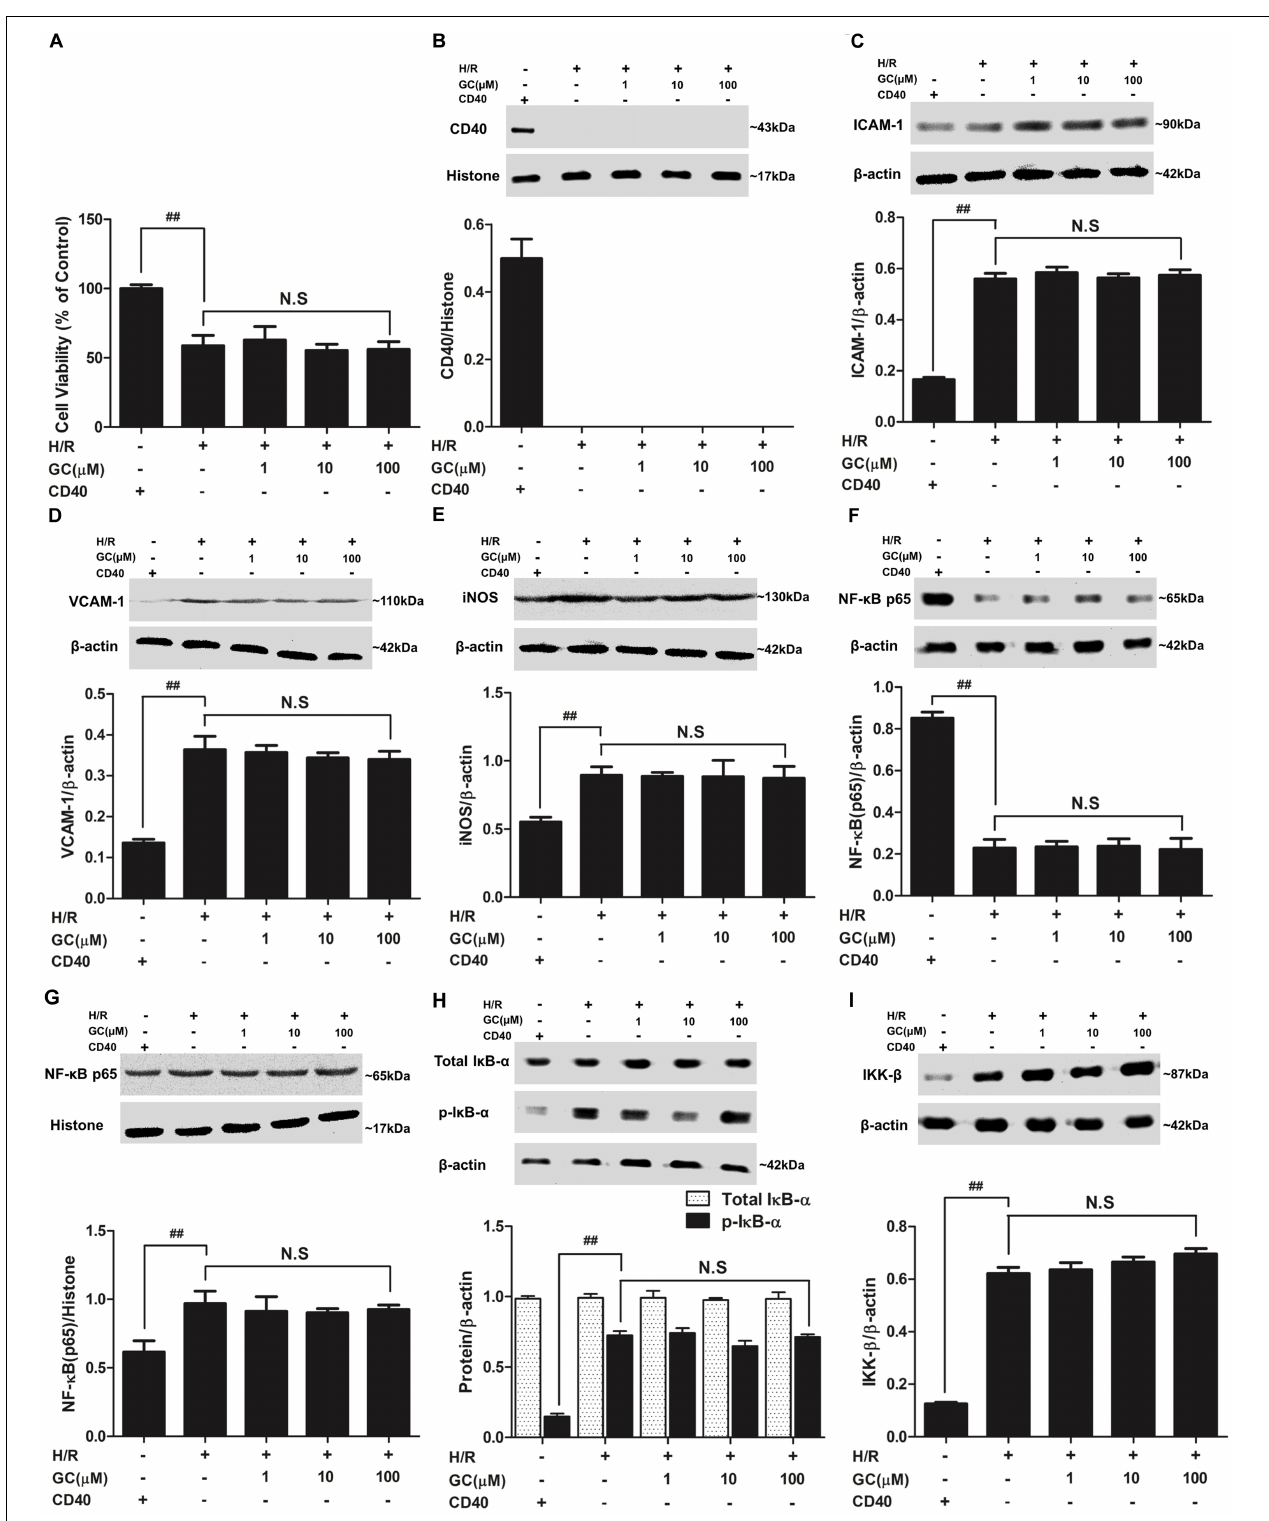
FIGURE 8 | Effects of GC on cell viability (A) and the expressions of (B) CD40, (C) ICAM-1, (D) VCAM-1, (E) iNOS, (F) cytoplasm NF- κ B p65, (G) nucleus NF- κ B p65, (H) p-I κ B- α and (I) IKK- β by Western blot after CD40 silencing procedure. Results were expressed as Protein/reference protein ratio. Data were expressed as mean ± SD of three independent experiments. ## P < 0.01 vs. control group; ∗ P < 0.05, ∗∗ P < 0.01 vs. H/R group.